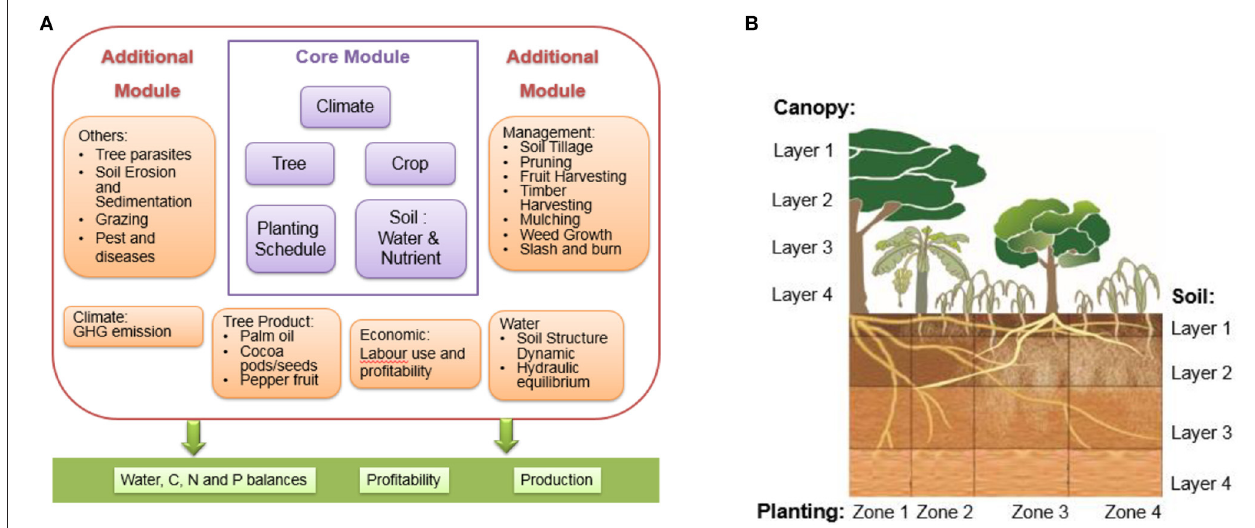
FIGURE 2 | Main modules in WaNuLCAS model that represent tree and crop in sharing light, water, and nutrient resources and its output (A) , configuration of the models planting zones for trees and crops, canopy layers and soil layers (B) .